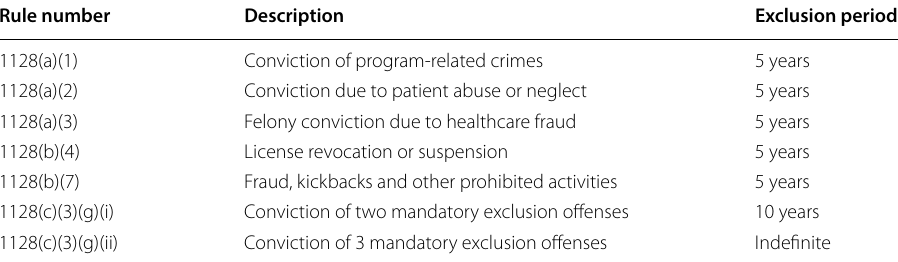
Table 2 Selected LEIE rules